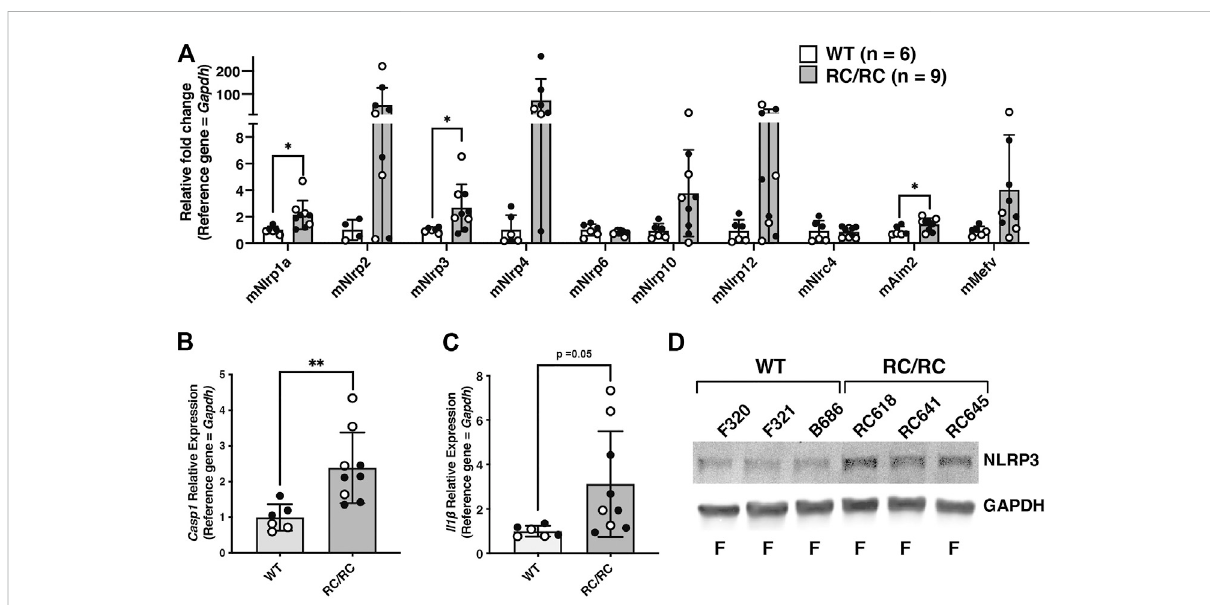
Expression of in fl ammasome sensors and components are elevated in kidneys from RC/RC mice. (A) qRT-PCR of transcripts encoding in fl ammasome sensors from kidneys of RC/RC or WT mice at 6 months of age. Open circles = females; closed circles = males. qRT-PCR